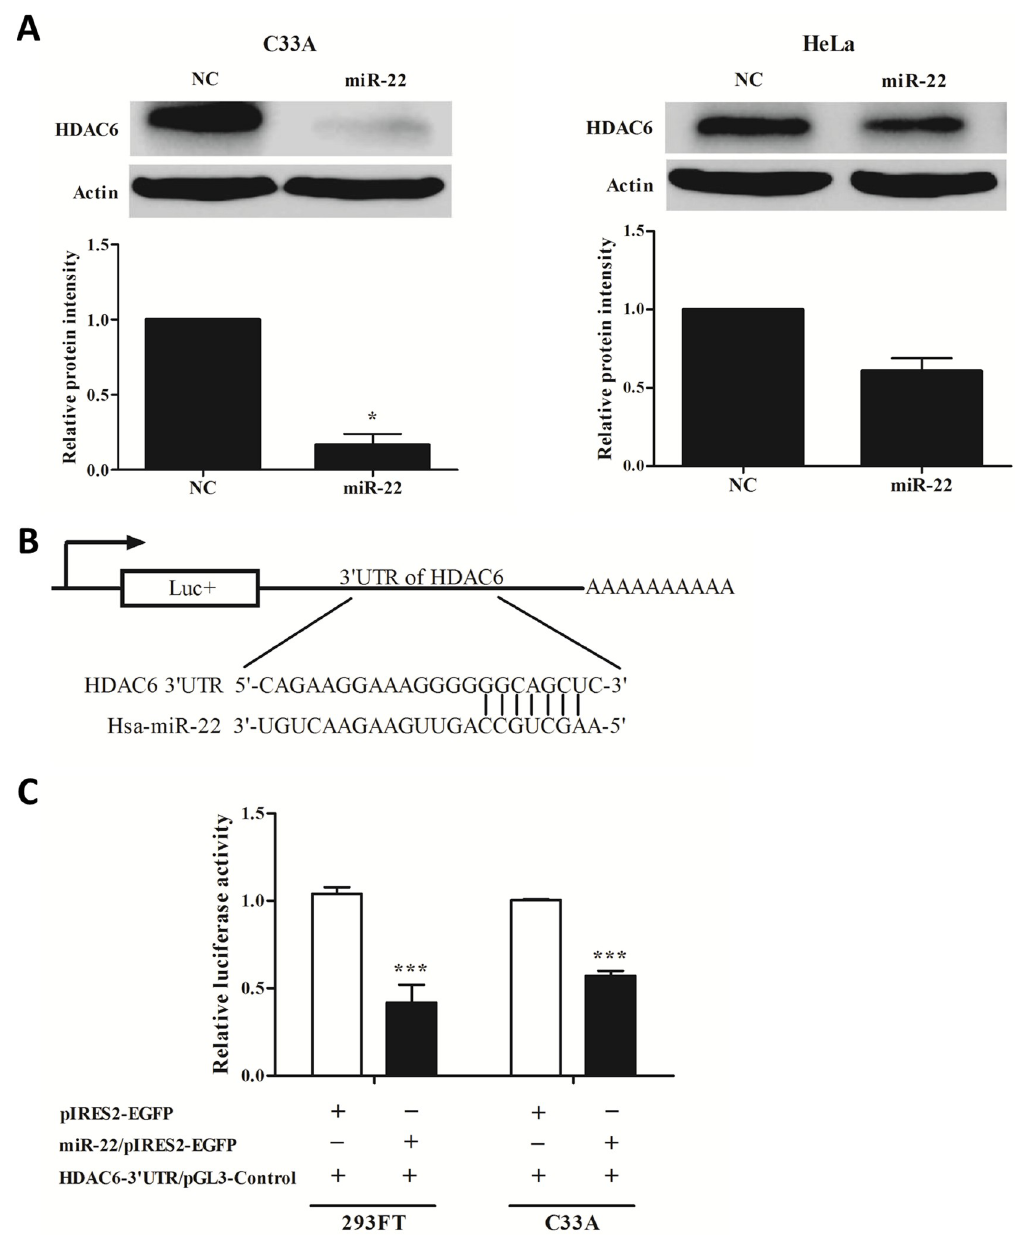
Fig 3. HDAC6 is a target of miR-22. A. miR-22 inhibited the expression of HDAC6 in cervical cancer cells. B. Predicted duplex formation between human HDAC6 and miR-22. C. The relative luciferase activities in 293FT and C33A cells were determined after the HDAC6 3’UTR plasmid was co-transfected with miR-22. Error bars indicate the standard error of the mean (SEM) of triplicated independent experiments. � P < 0.05, ��� P <